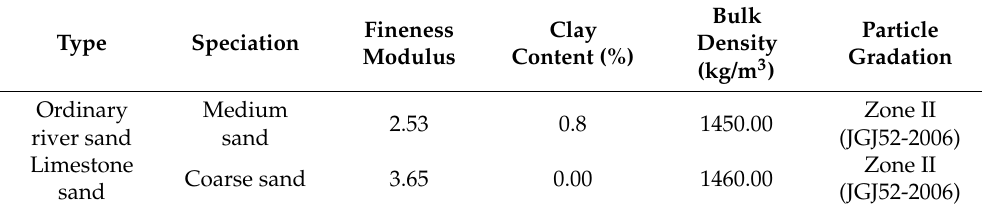
Table 2. The physical indexes of sand.